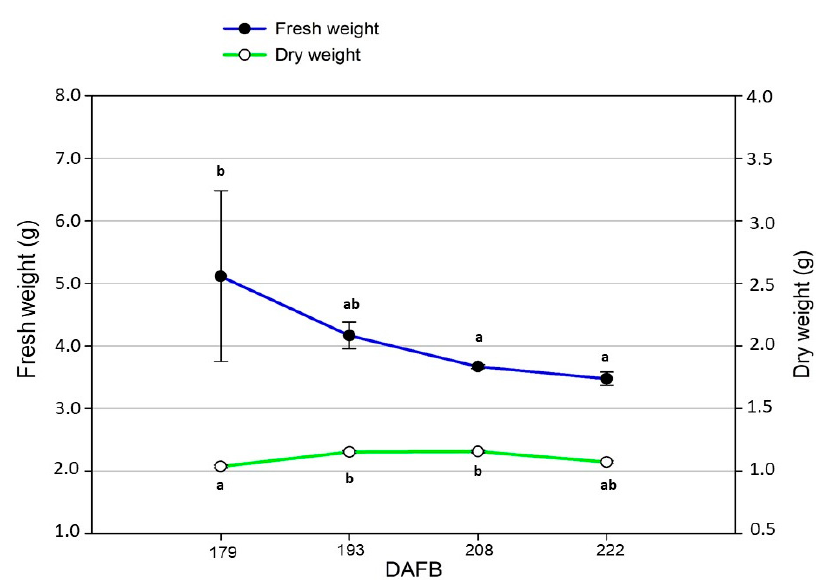
Figure 4. Fresh and dry weight (g) of olives of ‘Lecciana’ during ripening (DAFB = days after full bloom). Mean values of two subsequent seasons (± SE ). Lower case letters denote statistical differences at p = 0.05 (Siegel-Tukey test).